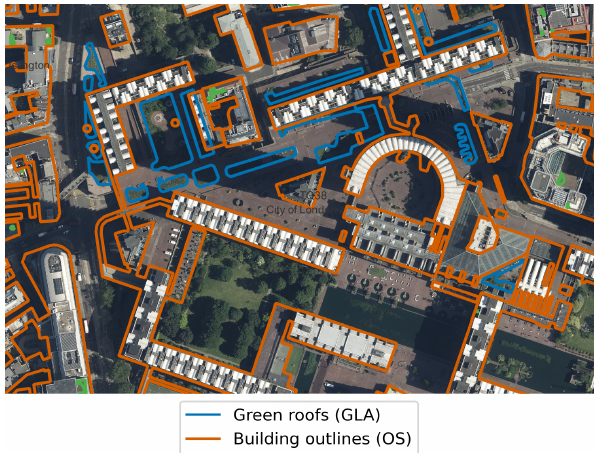
Figure A2. Example of disagreement between our result and the GLA dataset (Greater London Authority, 2014) (in blue) due to building outlines. Building outlines according to OS VML are shown in orange. The green areas of the Barbican Centre are excluded in our analysis, as the OS VML does not identify them as within a building footprint. Image location is shown in Fig. A3. Imagery © GetMapping Plc. Building polygons are OS data © Crown copyright and database rights